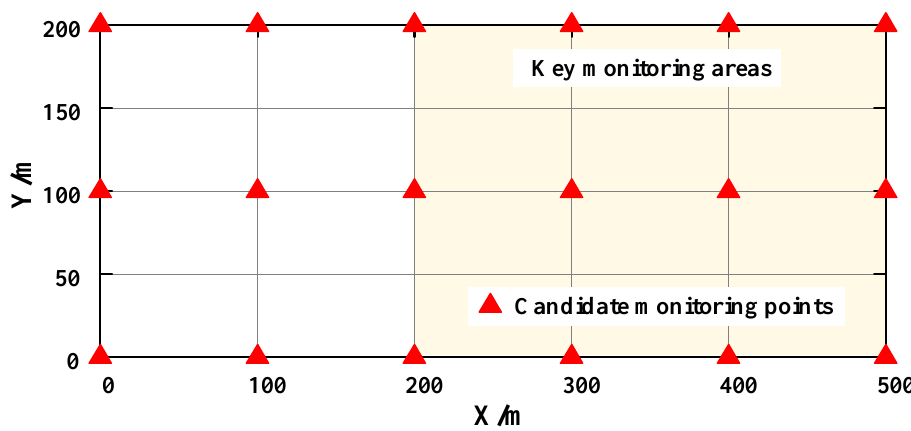
Figure 2. Distributions of candidate microseismic monitoring points.